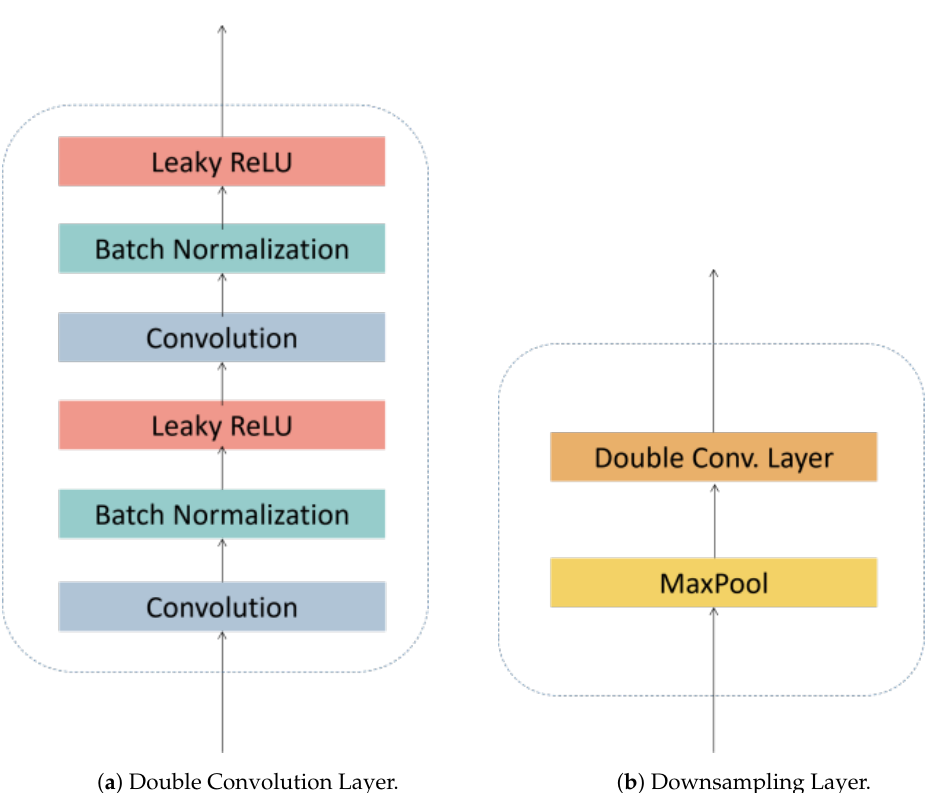
Figure 4. The architecture of the convolution layer in encoder.